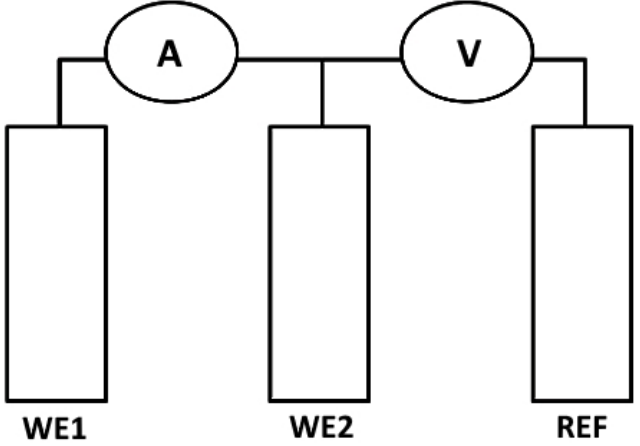
Figure 3. Schematic arrangement for ENM measurements.